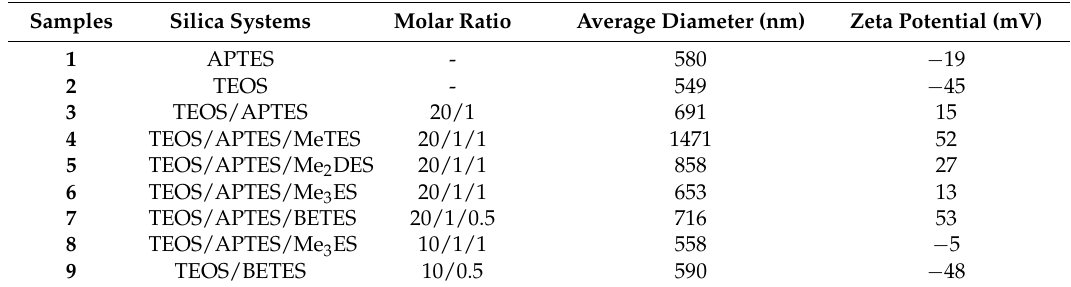
Table 2. Particle size and zeta potential values for the studied